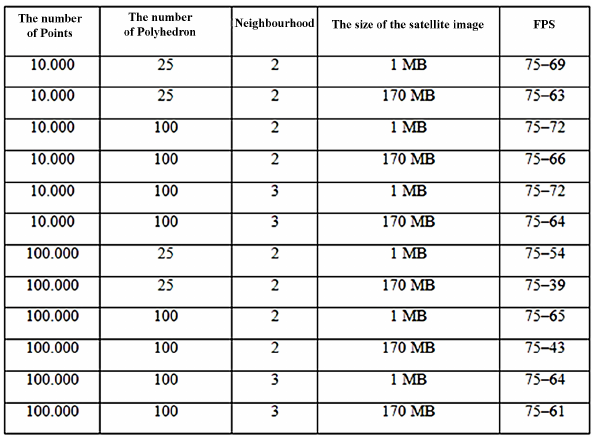
Figure 21. Performance results.